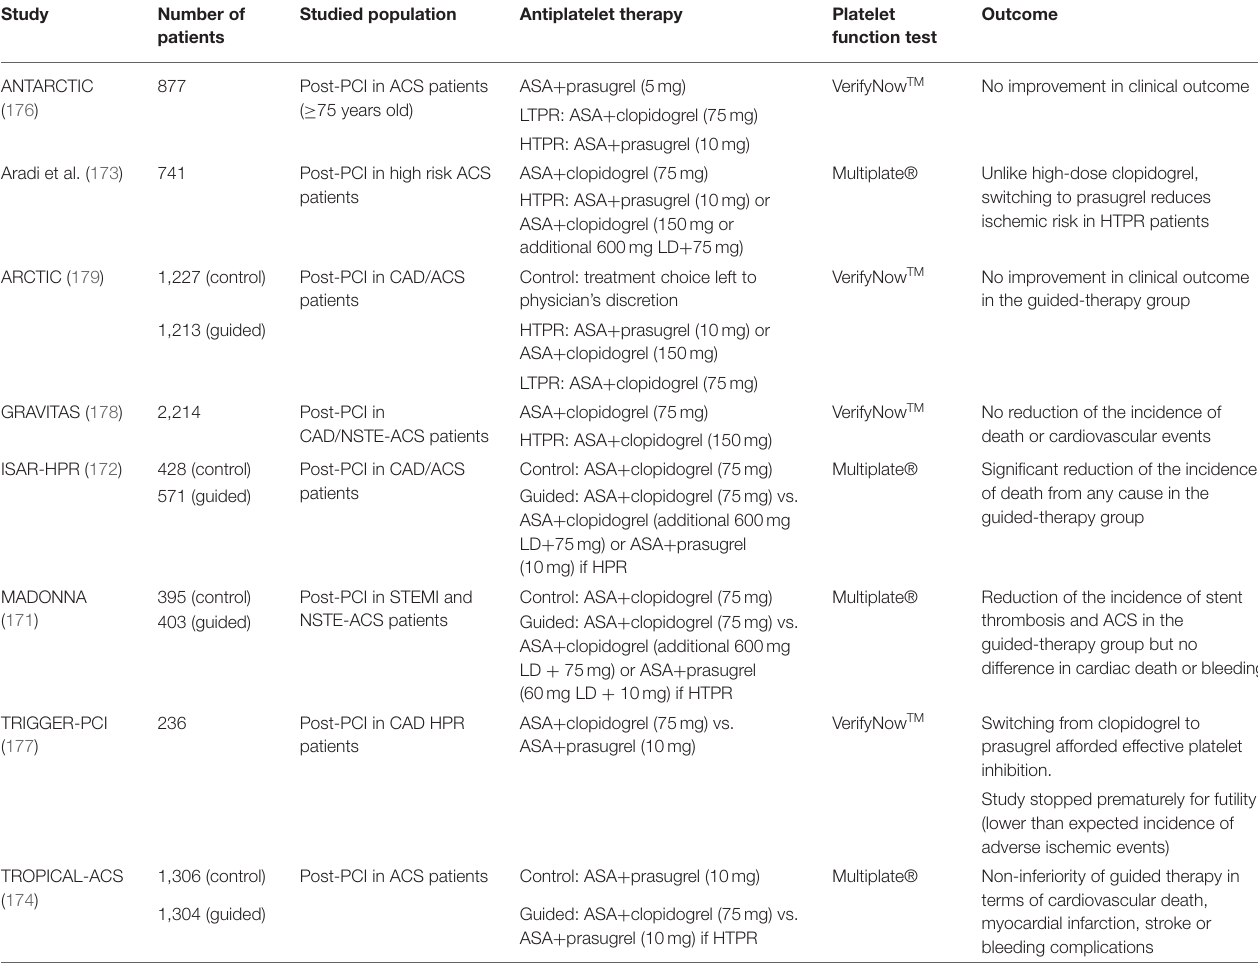
TABLE 4 | Clinical trials evaluating personalized antiplatelet therapy based exclusively on platelet function testing. Study